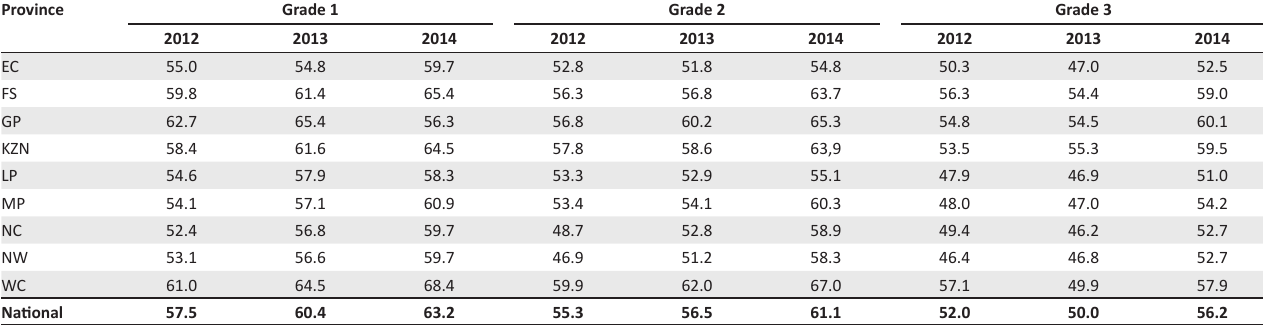
TABLE 1: Overall average results for Annual National Assessment (English home language) in the Foundation Phase.